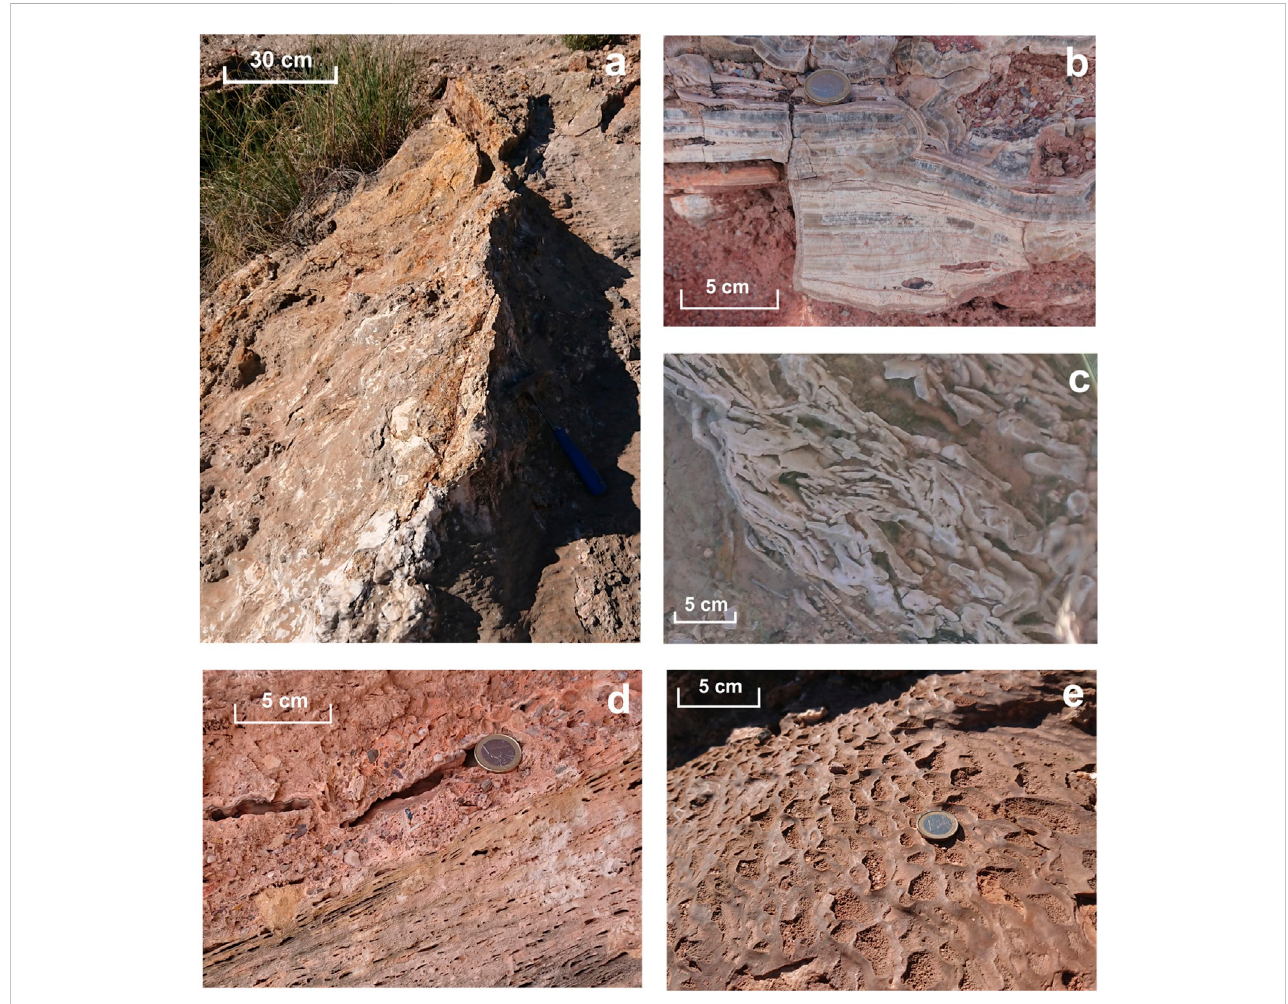
FIGURE 5 Field photographs of the different outcrops in Carraclaca site. (A) Close-up view of a fi ssure ridges travertine. The long central axis trends in a N-S direction and runs parallel to the secondary fracturing direction. (B) Close-up view of a crystalline crust travertine lithotype. (C) Example of travertine deposit with aFine-grained lithoclast lithofacies. (D) Bedded travertine with paper-thin raft lithofacies. (E) Close-up view of a minidam sedimentary structure. We can observe the irregular nature of the dams with a rough area inside and polished